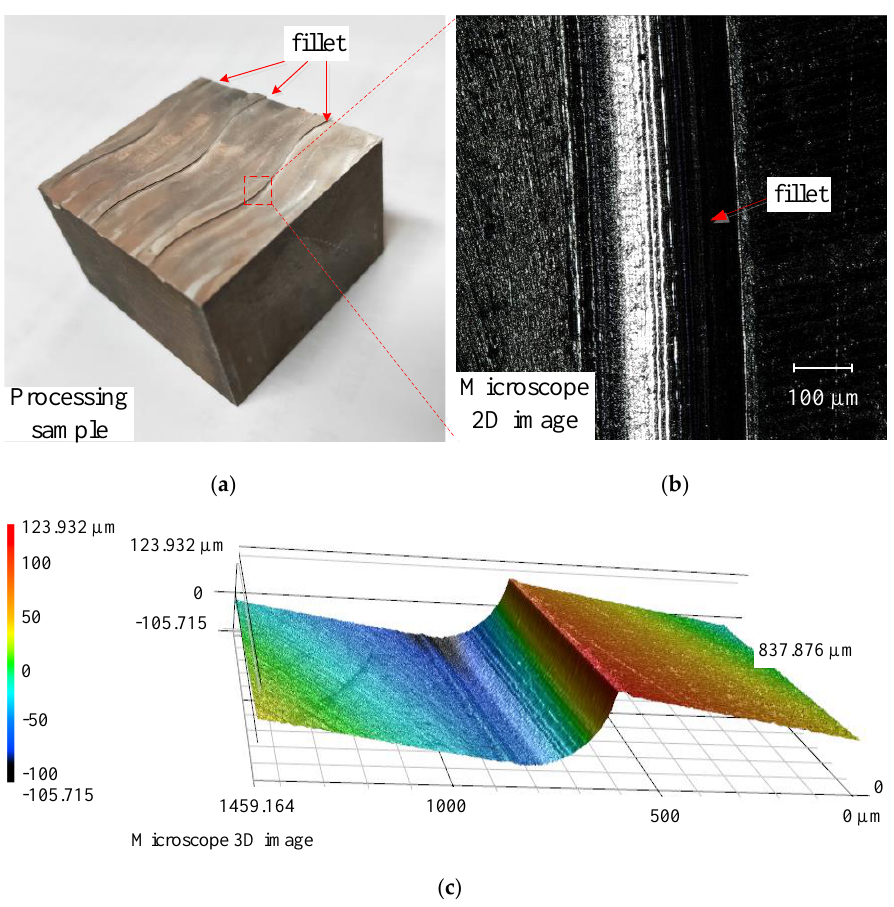
Figure 13. ( a ) Machining sample of fillet shape, ( b ) microscope 2D image, and ( c ) 3D image.